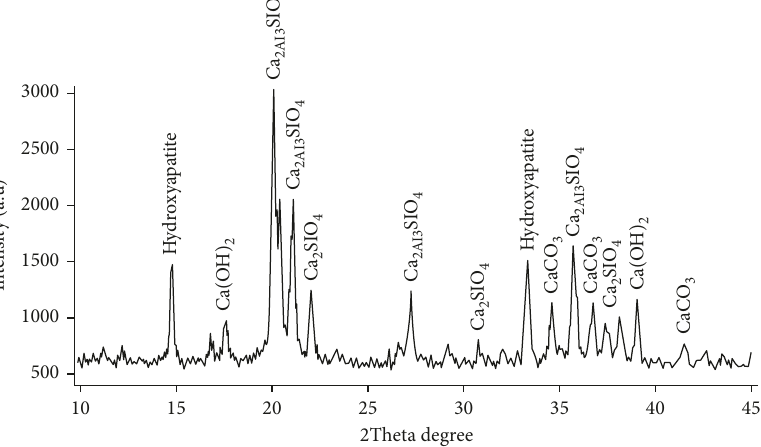
Figure 3: XRD of AA6061 +5 wt% snail shell.